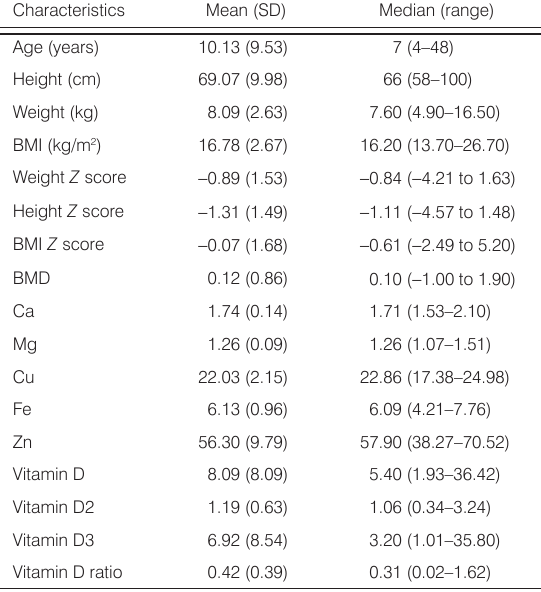
Table 1. Demographic characteristics of recipients. Note: SD: standard deviation; BMI: body mass index; BMD: bone mineral density; Ca: calcium; Mg: magnesium; Cu: cuprum; Fe: iron; Zn: